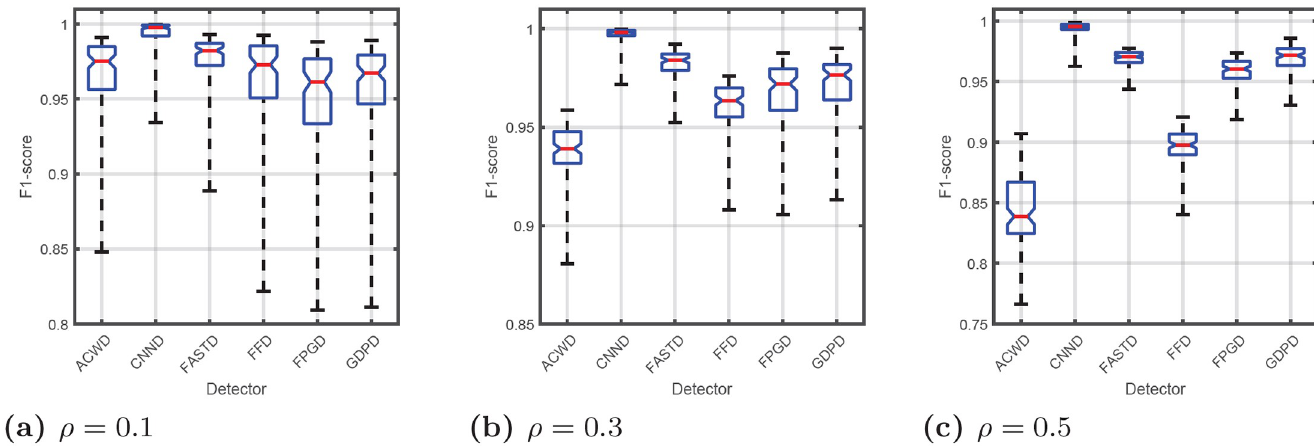
Best results are emboldened.